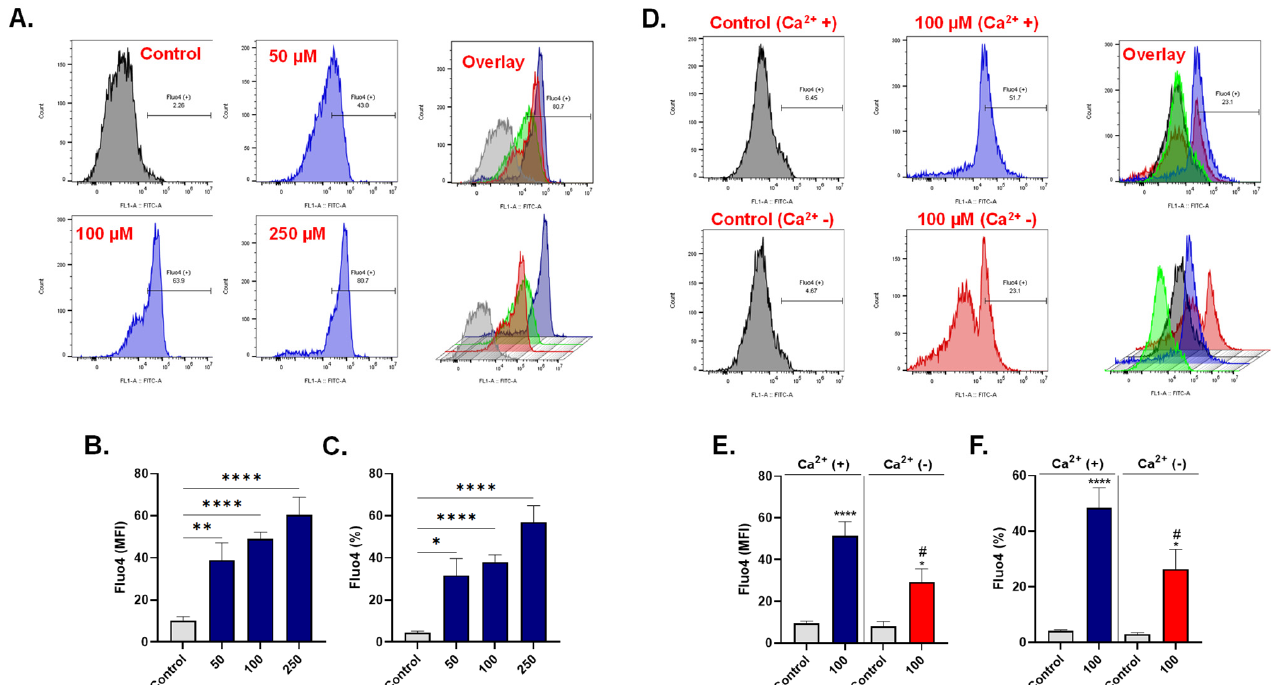
Figure 3. LA promotes extracellular Ca 2+ influx. ( A ) Representative histograms of Fluo4 of cells exposed to 0–250 µ M of LA. ( B ) LA-induced increase in MFI of Fluo4. ( C ) LA-induced increase in the percentage of Fluo4-positive cells. ( D ) Representative histograms of Fluo4 of cells exposed to 0–100 µ M of LA with and without Ca 2+ . ( E ) LA-induced increase in Fluo4 MFI with and without Ca 2+ . ( F ) LA-induced increase in the percentage of Fluo4-positive cells with and without Ca 2+ . ns indicates not significant, * ( p < 0.05), ** ( p < 0.01), and **** ( p < 0.0001) indicate significantly different values from control conditions whereas # ( p < 0.05) indicate statistical significance compared to LA-treated cells.